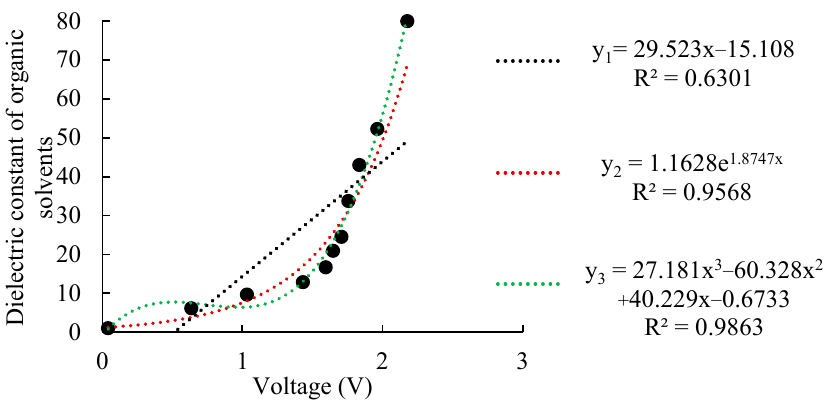
Figure 6. Data fit under normalized calibration.